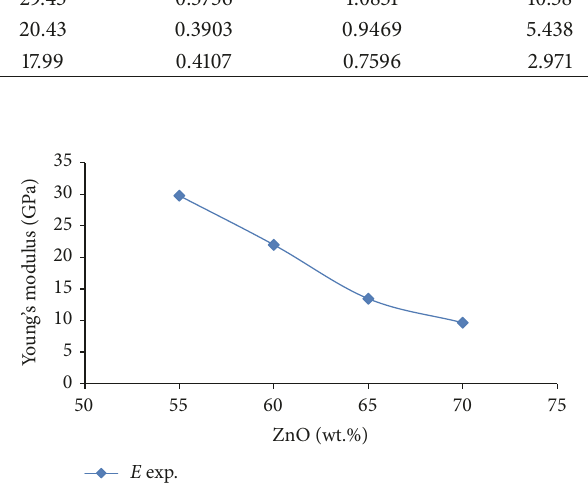
Figure 5: Young’s modulus versus wt.% of ZnO in ZnO–SiO 2